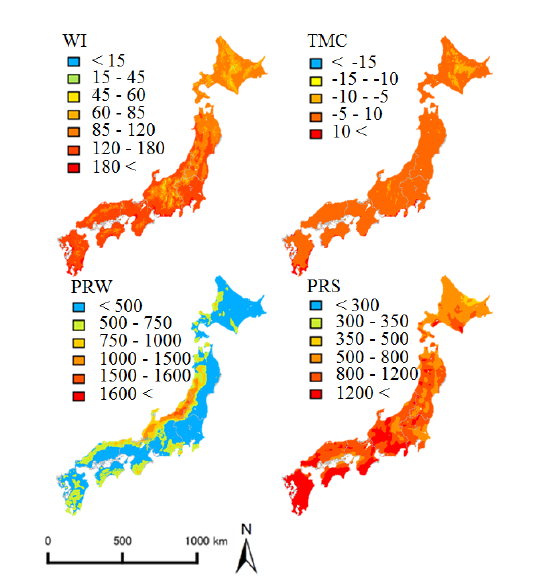
Figure 6. Distribution of future climatic variables for high- emissions